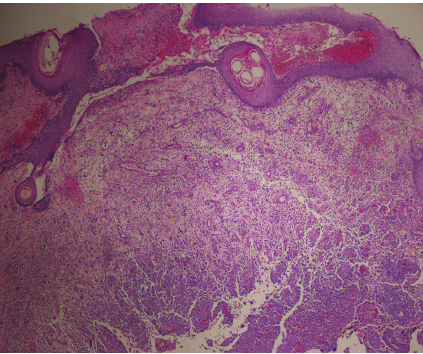
Figure 1: Ulcerated metastatic melanoma with solid growth pattern (HE × 40).